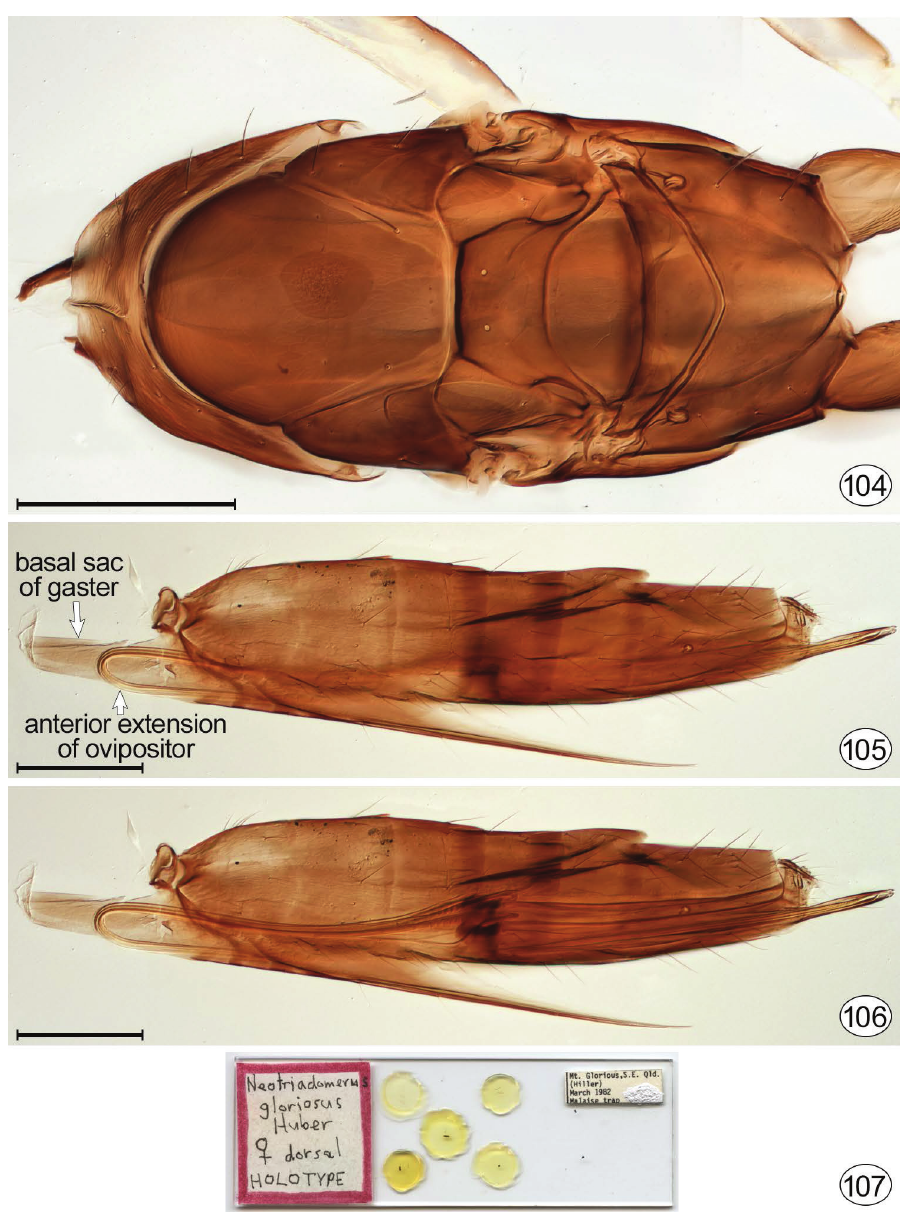
Figures 104–107. Neotriadomerus gloriosus , holotype. 104 mesosoma, dorsal 105 metasoma, lateral 106 metasoma, median plane 107 type slide. Scale bar = 200 μm. [measured along dorsal margin] 56, 28, and 64. Mesosoma. Width 324, length 711, with 2 propodeal setae (Fig. 104). Wings. Fore wing length 1367, width 486, length/ width 2.81, longest marginal setae 77; cubital line extending to just proximal to base